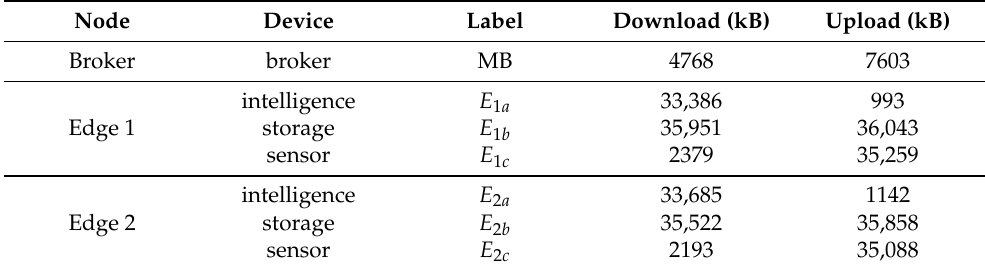
Table 5. Training: Network